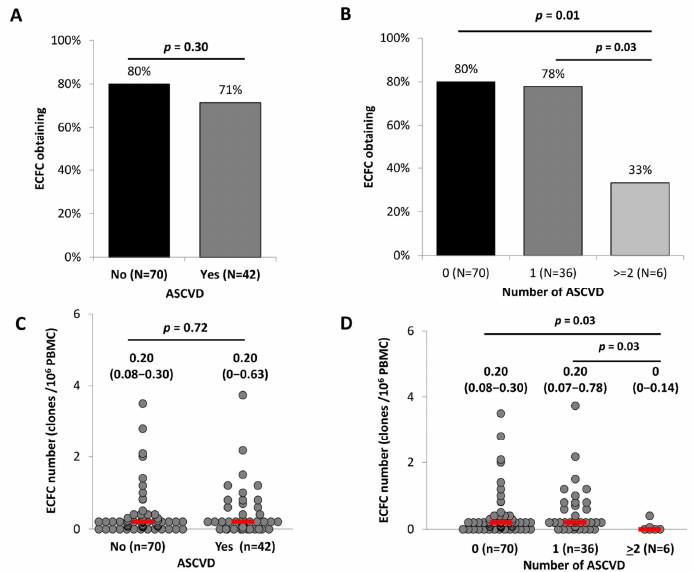
Figure 1. ECFC formation according to ACSVD presence and severity . PBMC from 112 patients were seeded onto gelatin-coated wells and observed every 2 days as described in Materials and Methods. ( A , B ) Colony progeny obtention (in%) in the presence or absence of ASCVD ( A ) or according to the extent of ASCVD ( B ). ( C , D ) Number of ECFC colonies formed by PBMC according to the presence or absence of ASCVD ( C ) or the extent of ASCVD ( D ). Data are presented as median (IQR) and percentages (%). ASCVD indicates atherosclerotic cardiovascular disease. p of comparisons are obtained from the Mann–Whitney or Khi2-test as appropriate.